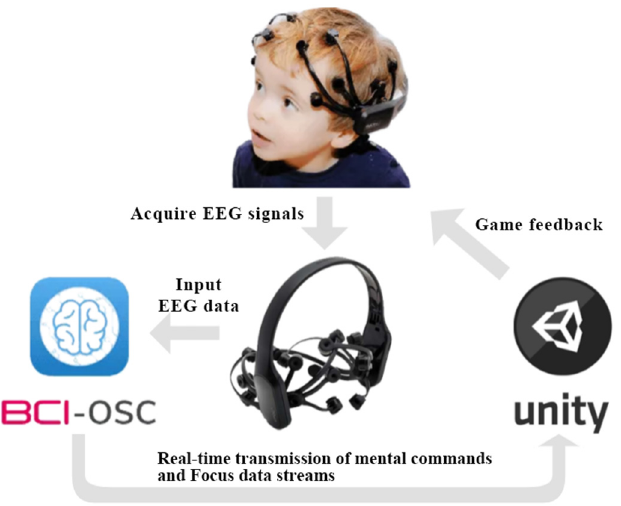
Figure 1. The overall framework of the training system (authors’ proposal).